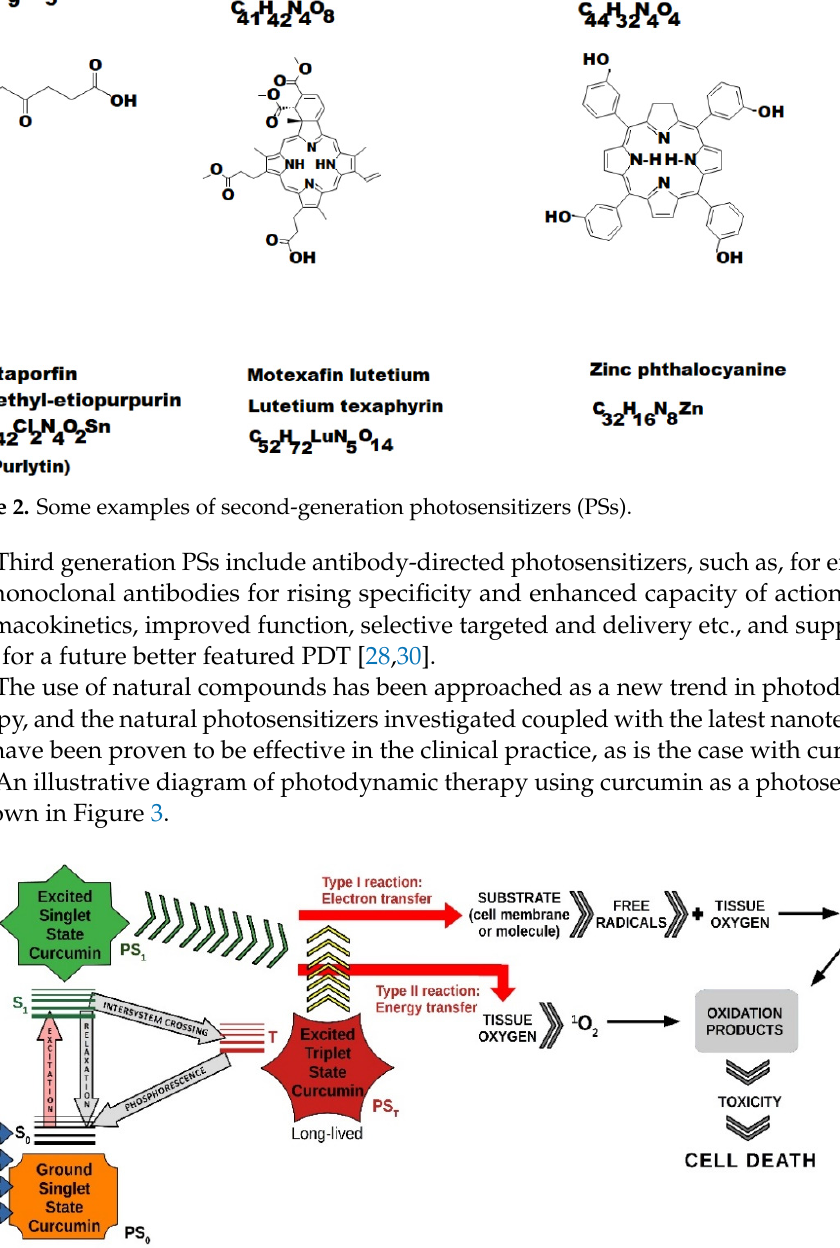
Figure 3. PDT with blue light and